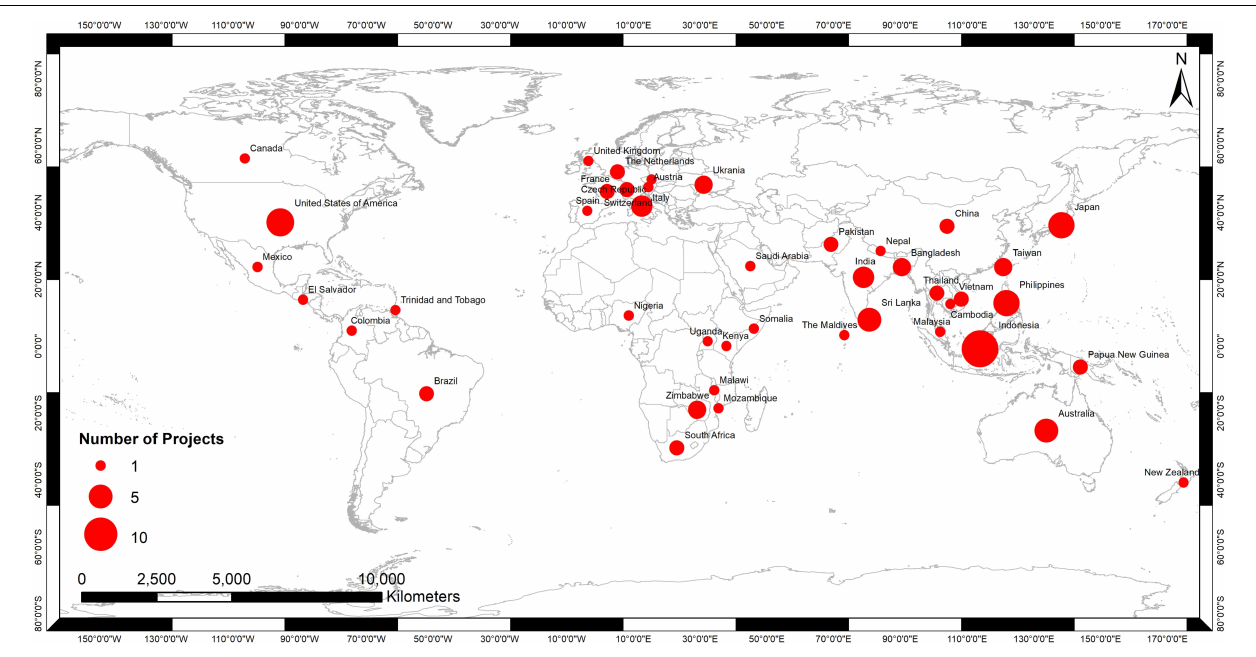
FIGURE 5 | Distribution of selected studies per study